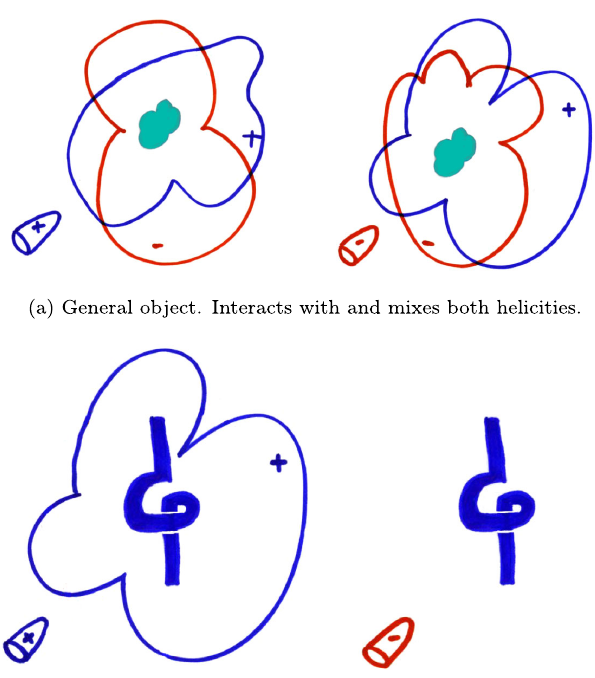
FIG. 2. Interaction of a general object (a) and a reciprocal maximally em-chiral object (b) with fields of pure helicity (cid:2) 1 . Fields of helicity þ 1 are blue and marked with a “ þ . ” Fields of helicity − 1 are red and marked with a “ − . ” Incoming fields are drawn as bulletlike shapes and scattered fields as clouds sur- rounding the scatterers. A general object interacts with and mixes both helicities (a). For reciprocal objects (b), maximal electro- magnetic chirality occurs if and only if the object is transparent to one helicity. It also implies that the object preserves helicity upon interaction: The scattered field has the same helicity as the incident field. The object hence must have electromagnetic duality